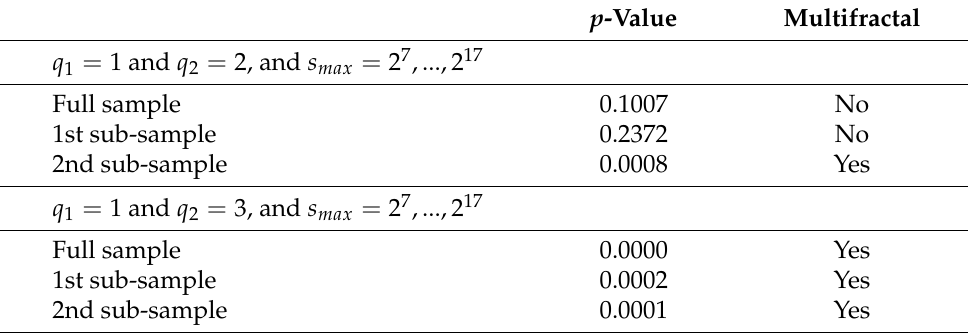
Table 5. Multifractality Wilcoxon rank-sum test for the full sample and sub-samples (splitting day: 16 July 2017).